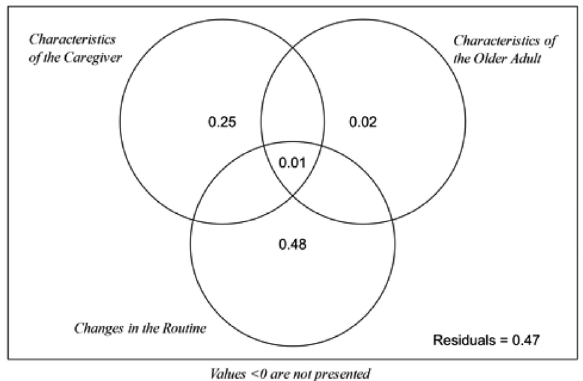
Figure 2. Variance partitioning of the matrix of characteristics of the caregiver, of the care receiver and changes in the routine, with exhibition of the respective percentages of unique and shared